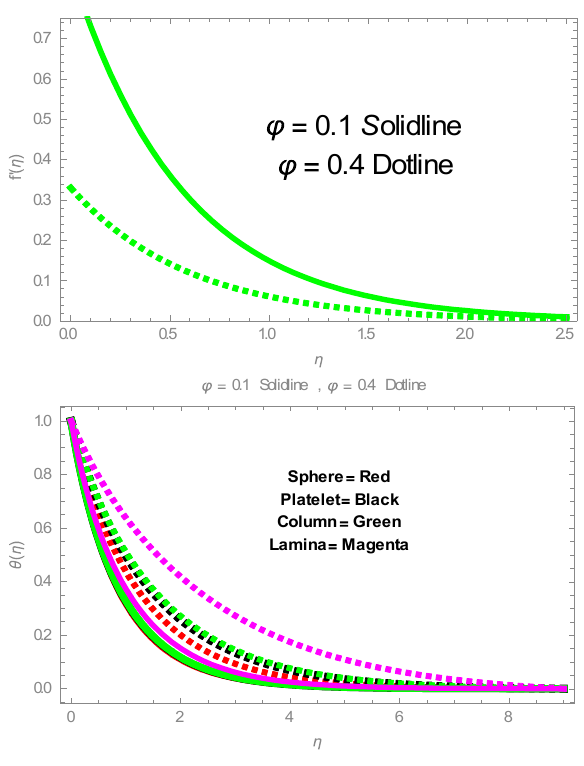
Figure 4. (cid:1858) (cid:4593) (η) and (cid:2016)(η) for dissimilar values of Kp .